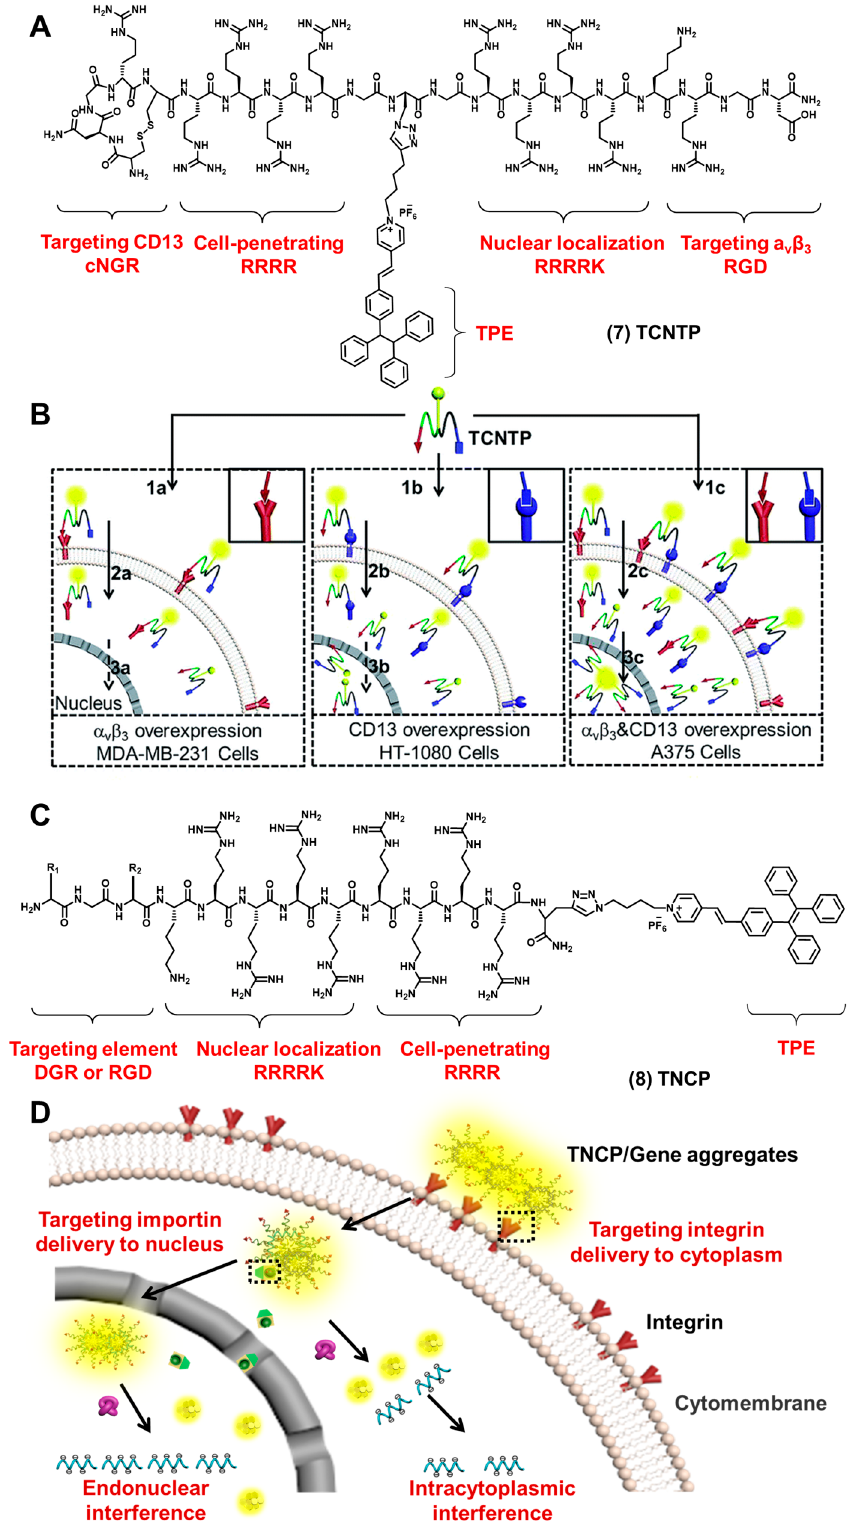
Figure 4. ( A ) The chemical structures of TCNTP. ( B ) The schematic illustration of TCNTP entering nucleus step by step by binding to the α V β 3 and CD13 receptors (permission to reprint this figure has been requested from [65]). ( C ) The chemical structures of TNCP. ( D ) The schematic illustration of TCNP/ASO aggregates for stepwise delivery and regional therapeutics (this figure was adapted from [66] with some modifications) .